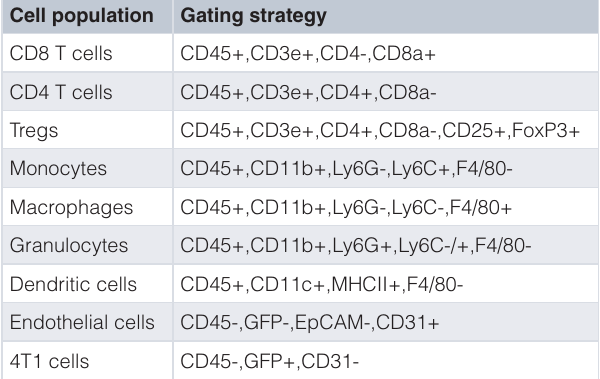
Table 2. Gating strategy used in flow cytometry